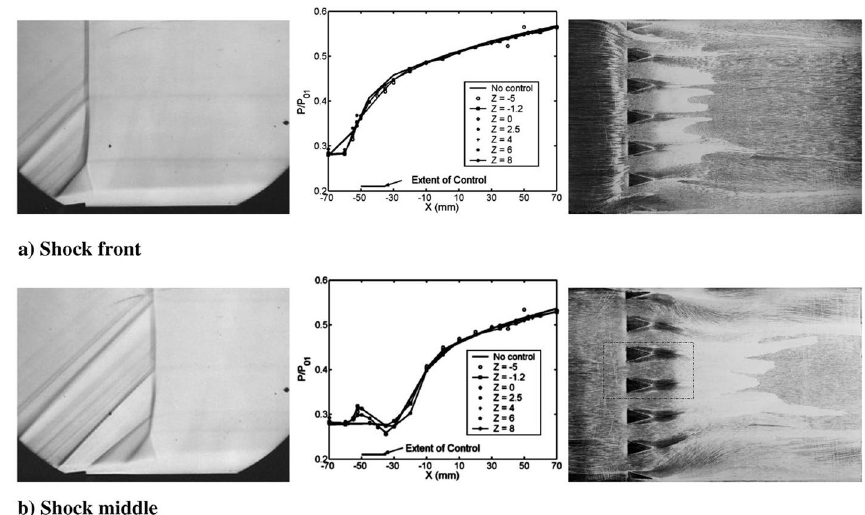
Fig. 15 Schlieren flow visualizations, wall pressure measurements, and surface oil-flow visualizations for Wedge-type Sub-Boundary Layer Vortex Generator